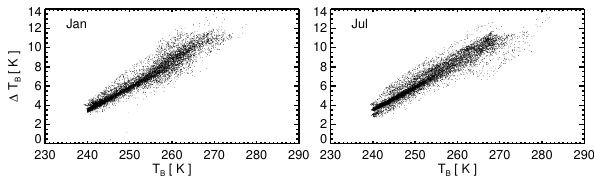
Fig. 6. RTTOV simulations of differences between microwave and HIRS T B s under clear-sky conditions for January and July